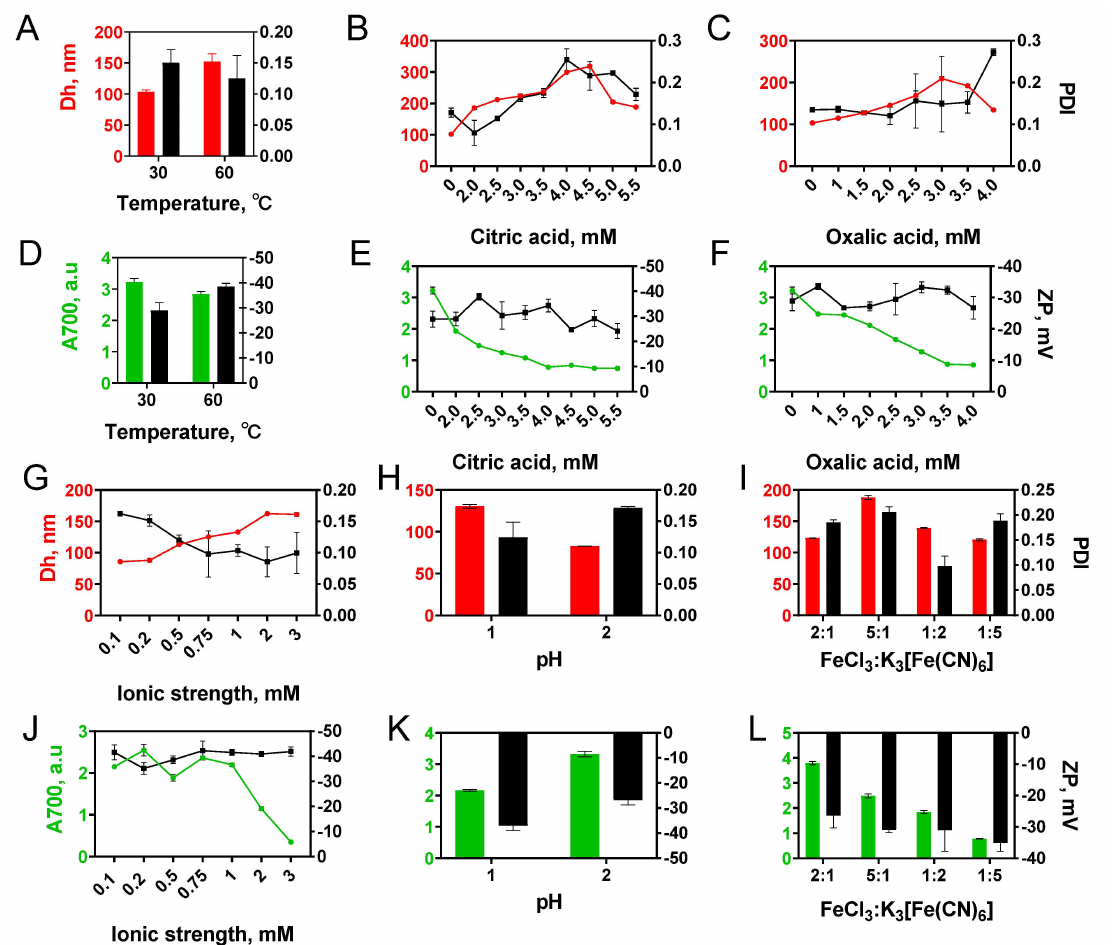
Figure 2. Influence of different factors: ( A , D ) temperature, ( B , E ) citric acid concentration, ( C , F ) oxalic acid concentration, ( G , J ) ionic strength, ( H , K ) pH, ( I , L ) molar ratios of FeCl 3 and K 3 [Fe(CN) 6 ] on the size (Dh), polydispersity (PDI) of nanoparticles, yield (A700), and zeta potential (ZP) of ‘artificial peroxidase’ nanozymes. n = 3, mean ±